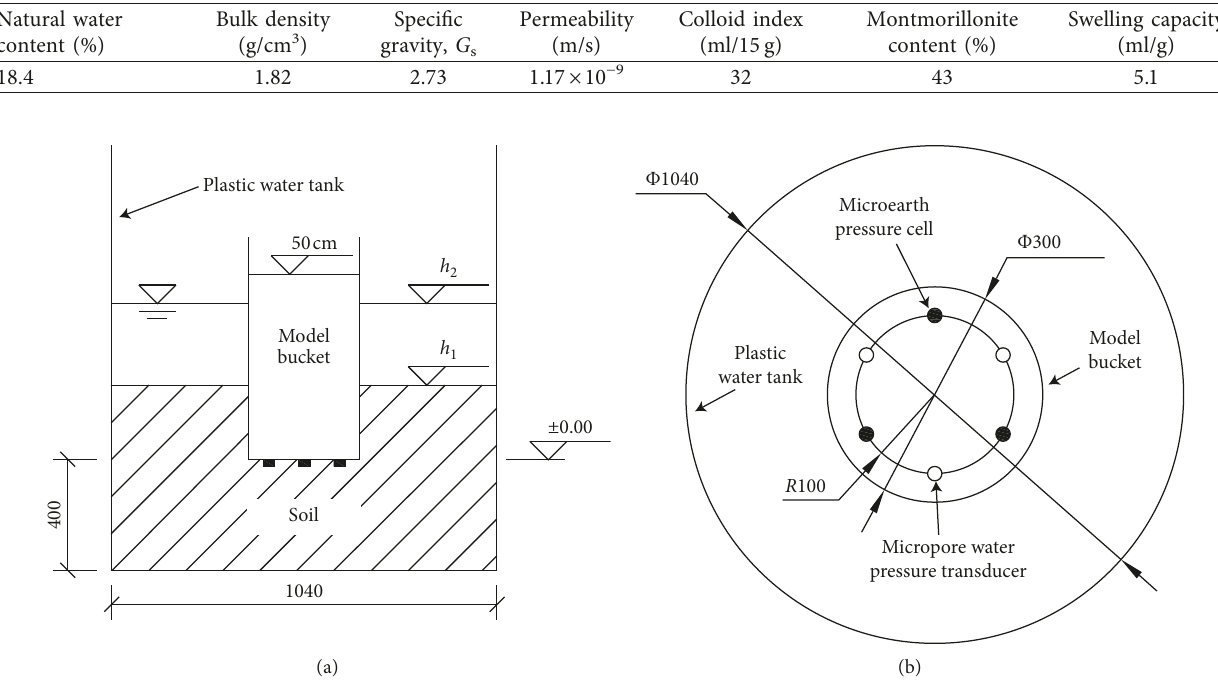
Table 2: Engineering properties of the soil samples.